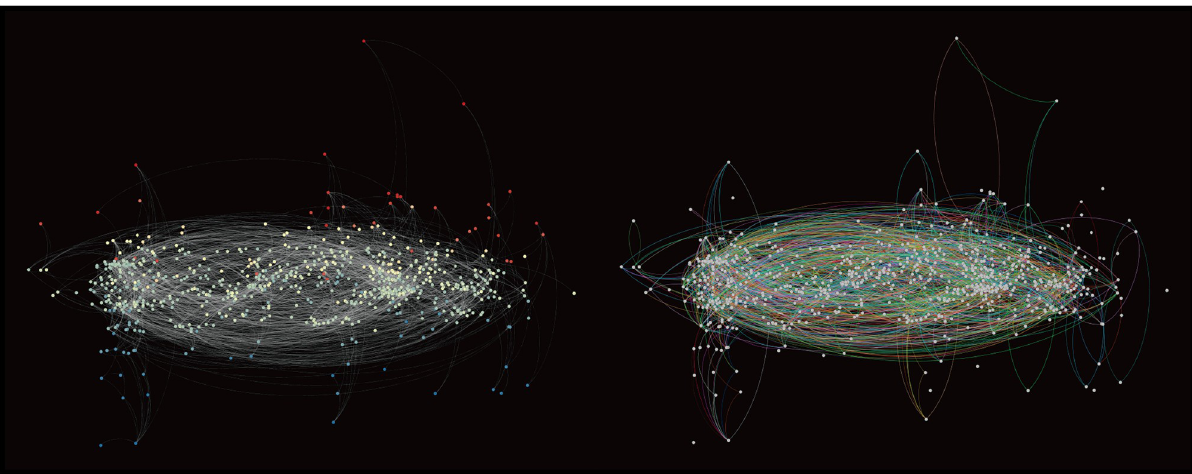
Fig 1. Visualisation of supply chains for top 1,000 firms in terms of sales. Each dot indicates a firm. Firms with a higher Helmholtz–Hodge (HH) potential are located more upward in both panels. In the left panel, the grey lines illustrate the potential flows computed from the HHD. The red and blue node colours represent higher and lower HH potentials, respectively. The right panel shows loop flows computed from HHD, while the different colours represent different cycles.